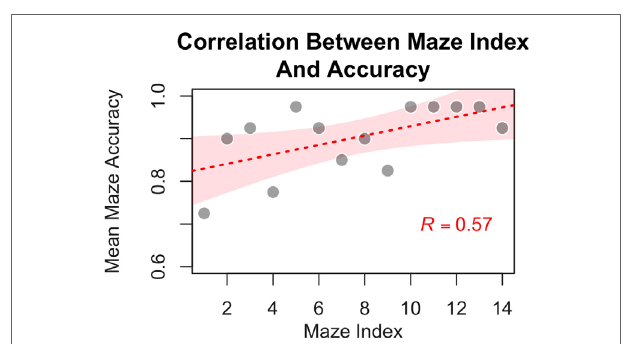
FigUre 9 | Participants showed improved accuracy for mazes in the experimental condition as a function of time (i.e., with increasing experience with the navigational task, as evidenced by a significant correlation between mean group performance on a maze and the maze position within the experiment) . The individual dots represent average performances for the specific mazes, the red line represents best fitting linear relationship (intercept: 0.81; beta = 0.011), and the shaded contour represents the 95% confidence interval of the